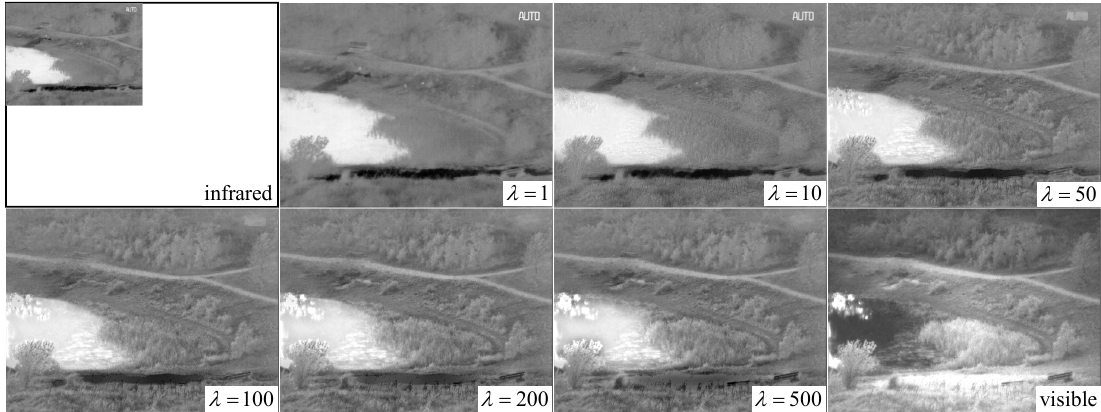
Figure 4. Fusion results of our DRTV on nato_camp_sequence when parameter λ increases.